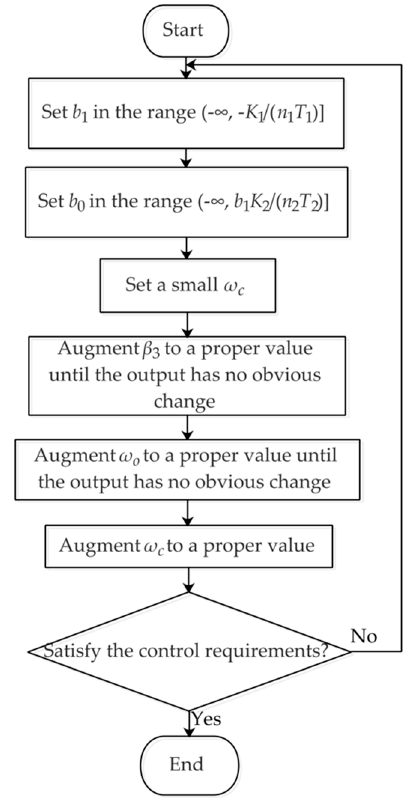
Figure 12. Flow chart of the hybrid ADRC tuning.